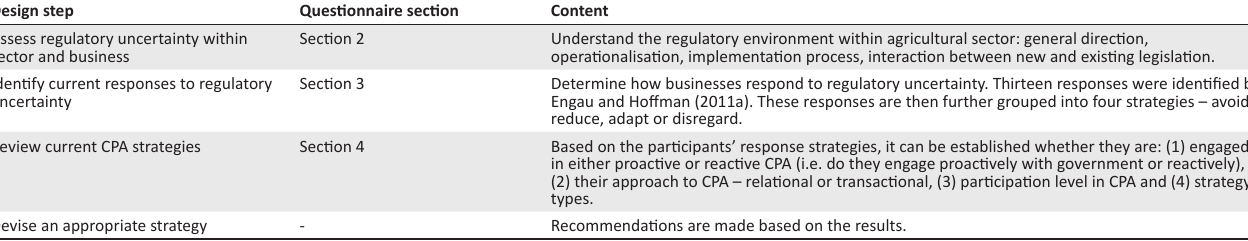
FIGURE 1: Corporate political TABLE 1: Empirical framework to establish enterprise strategy during times of regulatory uncertainty.